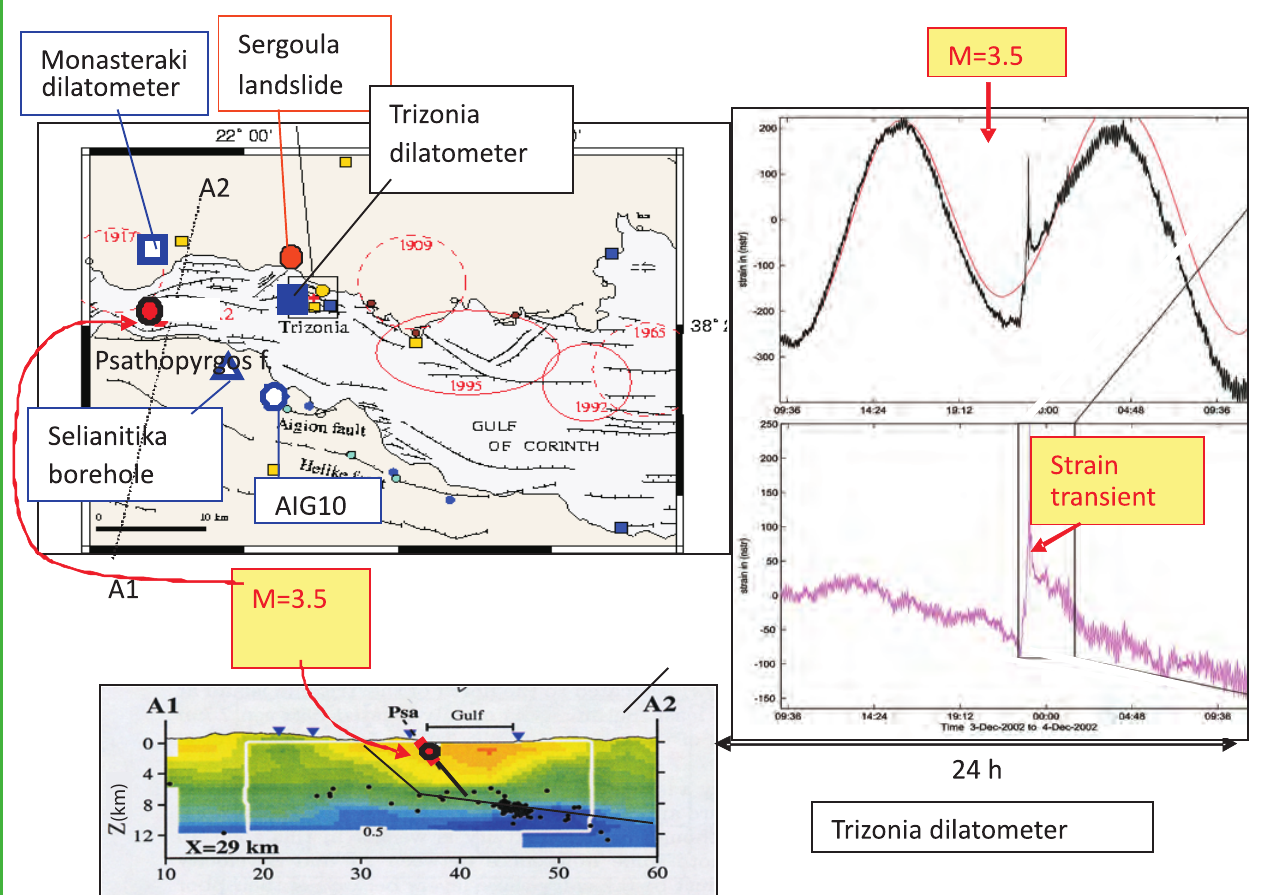
Figure 4 . Strain transients at CRL. Top left: Continuous strain-related observation array. Blue open circle: AIG10 borehole; Blue square: Trizonia dilatometer borehole; open blue square: Monasteraki borehole dilatometer, planned June 2006; Open blue triangle: Selianitika borehole; Yellow squares: continuous GPS; Blue dots: pore pressure in aquifers; Green square: geochemical station in aquifer; Green circle: radon probes on fault scarp. Black/Red circle: shallow 2002 earthquake coincident with the recorded strain transient; Top right: 24-hour record of the Trizonia dilatometer (3-12-2002). Red curve, top: synthetic of the tidal effect; bottom: data after tide removed. Note the one-hour-long transient dilatation, peaking with the M3.5 event (Bernard et al., 2006). Short period fluctuations are the pressure effect due to the free oscillations of the gulf. Bottom left: NS cross-section of the Psathopyrgos fault. Red and black circle: M3.5 event; Red segment: possibly creeping shallow Psathopyrgos fault, likely source of the strain